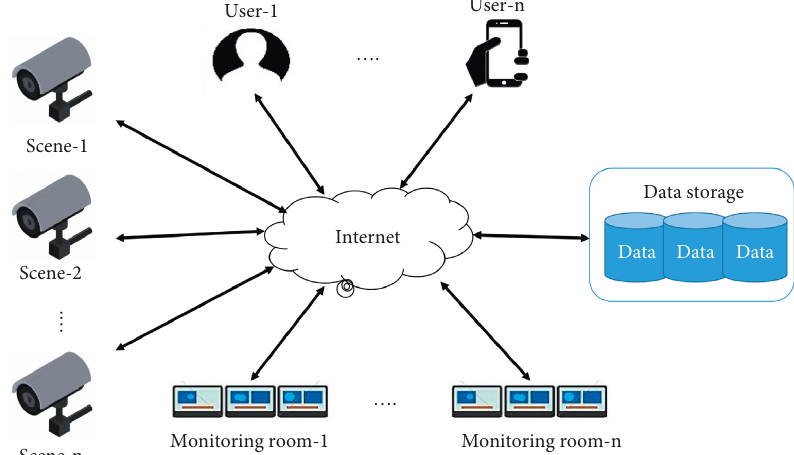
Figure 1: The architecture of a video surveillance system.